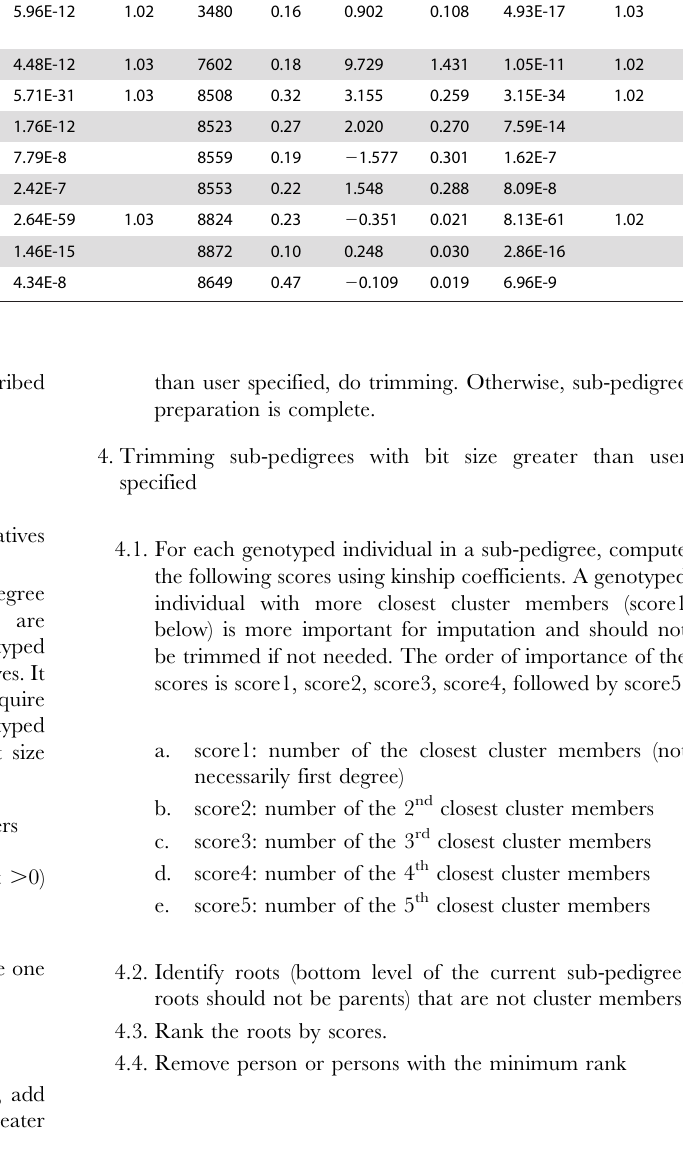
Table 4. Number of genome-wide significant SNPs (p-value , 1.25E-7) with improved statistical significance (smaller p-value) from GWAS of Alzheimer disease, fibrinogen, HDL and uric acid using incorporated genotype data (new GWAS).